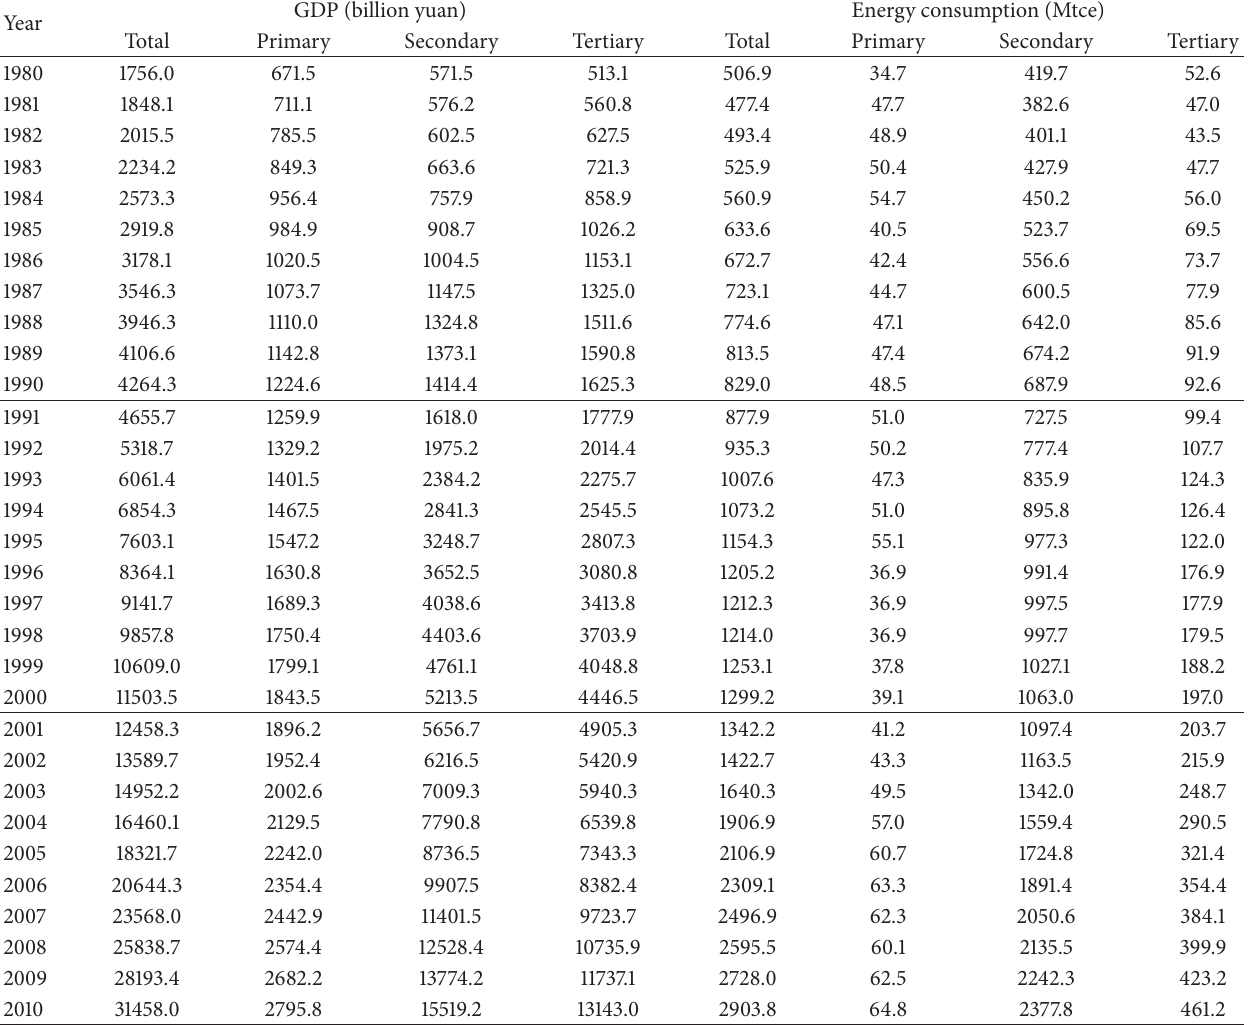
Table 1: China’s GDP and energy consumption by industrial